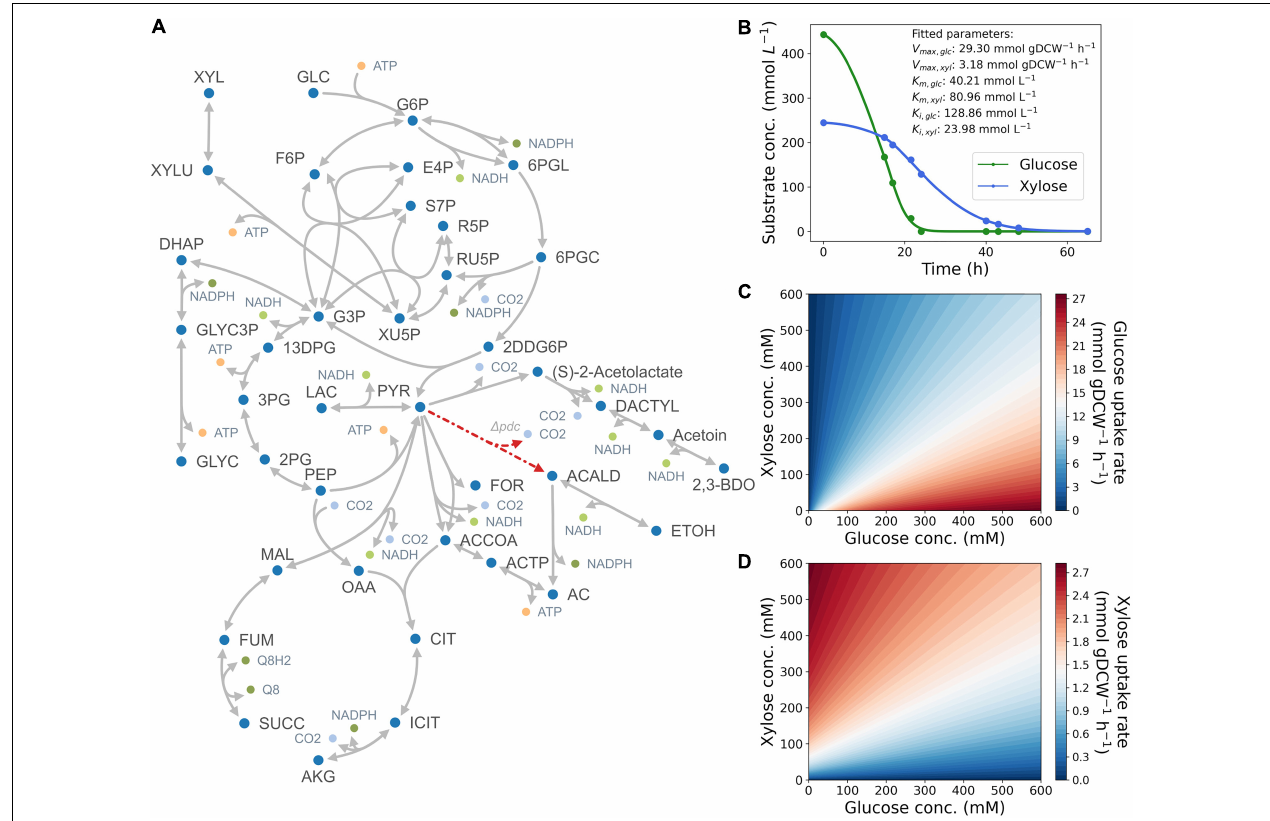
FIGURE 1 | (A) Map of core-carbon metabolism in the engineered Z. mobilis strain. A list of abbreviations used are shown in Supplementary Table 1 . (B) Kinetic properties of glucose facilitator (glf) in Z. mobilis BC42C (cid:49) pdc. Kinetic parameters (V max , K m , and K i ) are estimated by fitting the time-course utilization of glucose (green) and xylose (blue) with coefficient of determination R 2 = 0.99. Dots denote experimental data points, and lines denote the best fit curve of substrates uptake kinetics. (C,D) Contour plots illustrating substrate uptake rates as a function of glucose (C) and xylose (D)